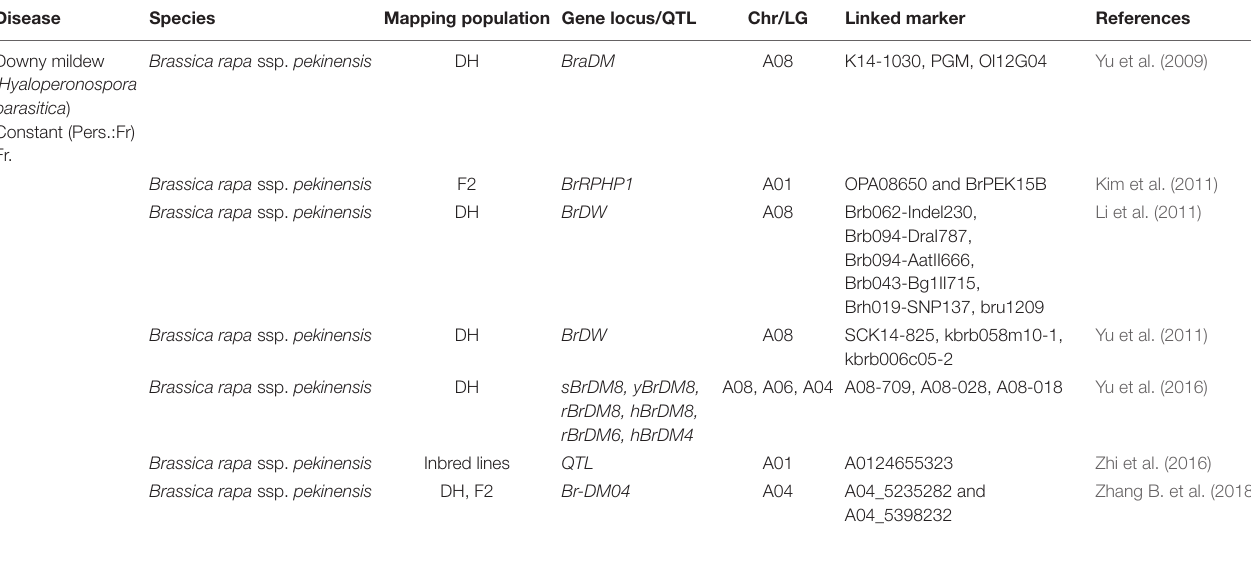
TABLE 2 | List of genes/QTLs associated with Downy mildew resistance in related Brassica species. Disease Species Mapping population Gene